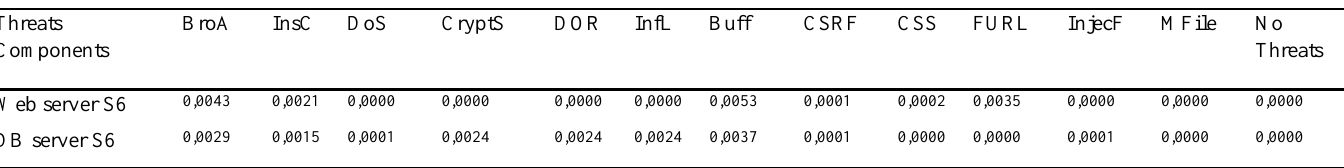
Table 11: The Impact Matrix S6 (IM S6)